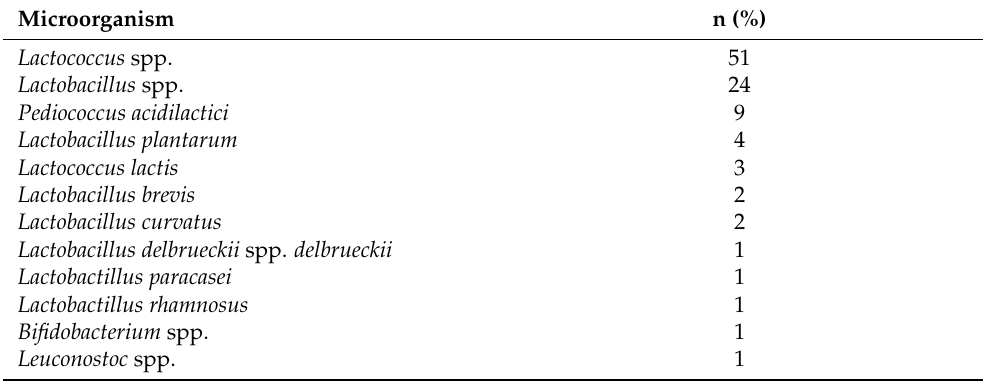
Table 2. Lactic acid-producing bacteria isolated from canine vaginal swabs. Microorganism n